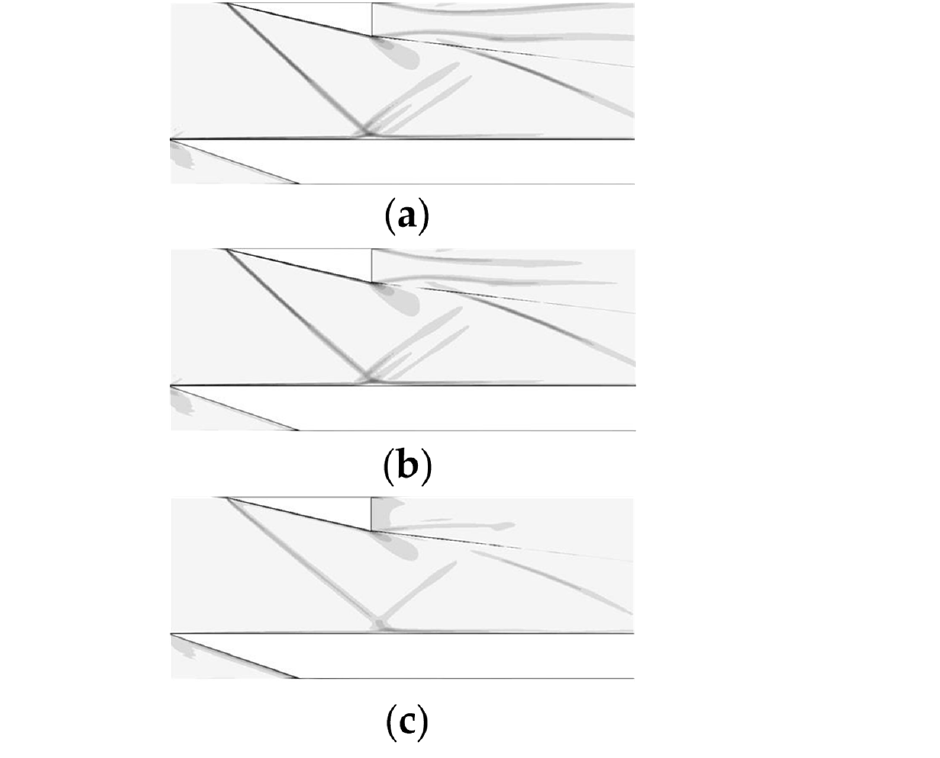
Figure 10. Density gradient contour of different cross sections: ( a ) z = 0; ( b ) z = 0.025 m; ( c ) z = 0.054 m. The velocity contour in the ISWBLI zone was further analyzed. Figure 11 shows the velocity contour at the y = 0 cross section. Velocity u represents the velocity in the x -axis direction of the flow field, and the region where Velocity u is less than 0 is defined as the separation zone, which is showed in blue in Figure 11. The calculation results show that the separation zone induced by the incident oblique shock wave was crescent shaped, and the length of the separation zone reached its peak at the central section of the plate and decreased spanwise. The separation zone had a width smaller than that of the shock wave generator and the plate and basically disappeared at the edge of the plate. These outcomes demonstrate that the ISWBLI flow field has significant, spanwise, three-dimensional characteristics, which is consistent with the conclusion extracted from Figure 10.